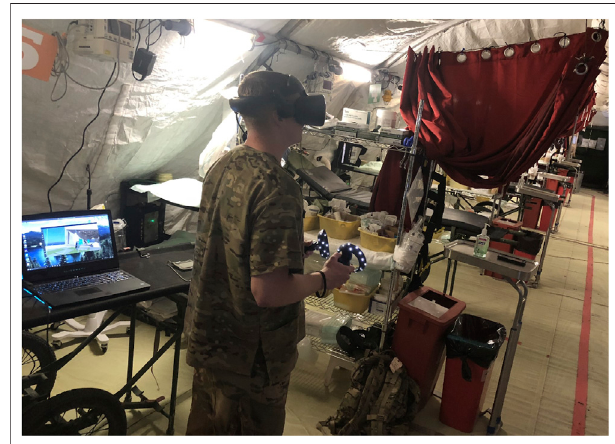
FIGURE 6 | The simulator works without an instructor and does not need an internet connection. The authors took a headset and laptop on a deployment to Iraq. In this panel, a combat medic can be seen using a beta version of the VR simulator in 2019.